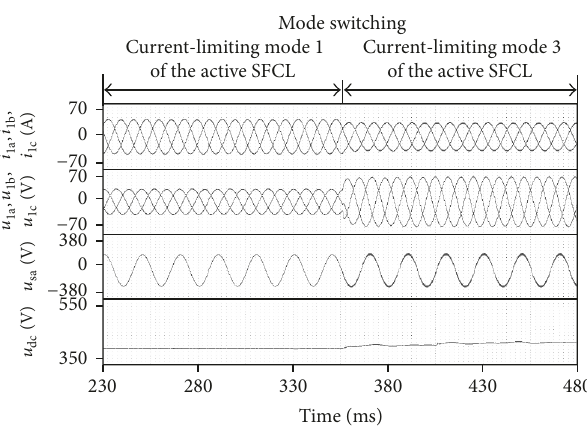
Figure 11: Performance of the active SFCL prototype corresponding to mode 3 under the current-limiting test. the grid-side power; 𝐶 is the capacitor; 𝑉 is the DC-link dc 1 dc 1 voltage over the